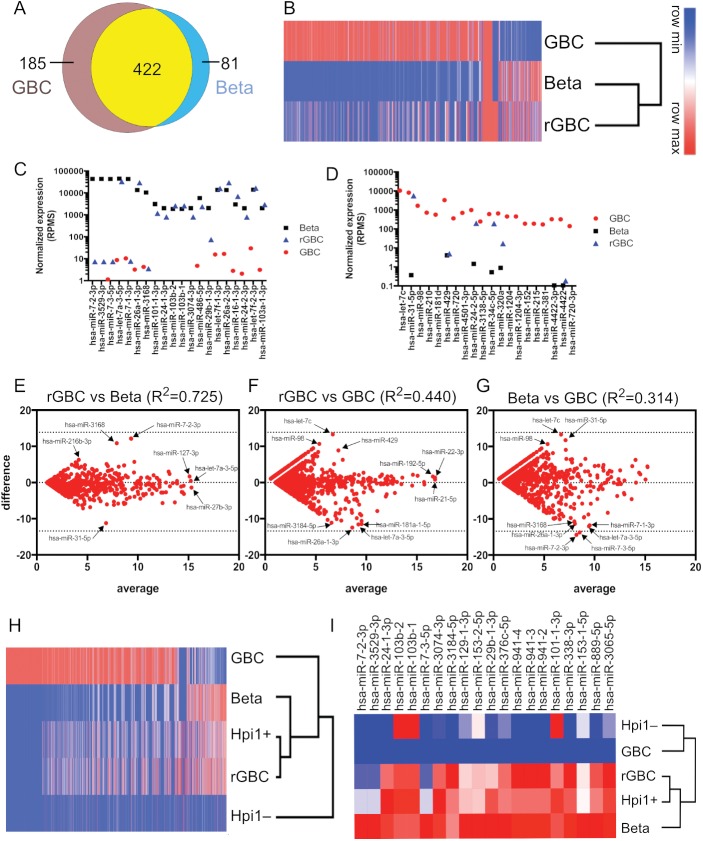
Determination of microRNA expression in rGBC relative to human pancreatic β cells and primary GBC by Illumina sequencing.(A) Venn diagram of microRNAs differentially expressed in human pancreatic β cells (blue) or primary GBCs (brown) or no difference (yellow). (B) Heat map and dendogram of microRNAs in β cells, primary GBC, and rGBC. (C,D) Top twenty differentially expressed microRNAs enriched in β cells (C) and GBC (D). (E-G) Bland-Altman plots comparing the microRNA populations in β cells, primary GBC, and rGBC. Y-axes correspond to expression differences [log2(rGBC–β, GBC–rGBC, GBC–β, respectively)] and the X-axes correspond to average value of each microRNA in each paired cell types. Selected microRNAs are annotated to illustrate differential expression among the three cell types. (H) Hierarchical cluster analysis of microRNAs in Hpi1 subpopulations relative to unsorted rGBC, primary GBC, and β cells. (I) Heat map distribution of the twenty most differentially expressed microRNAs enriched in β cells and downregulated or absent in primary GBC across clustered cell types.